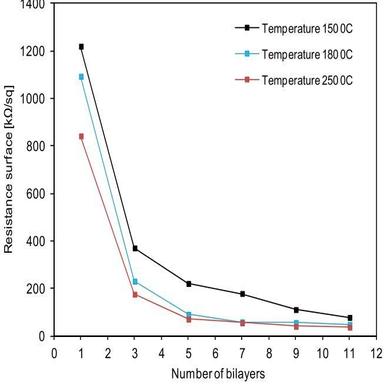
The surface resistance of multilayers films (PEI/rGO)n on quartz plates after thermal reduction in different temperatures (150 °C, 180 °C, 250 °C).